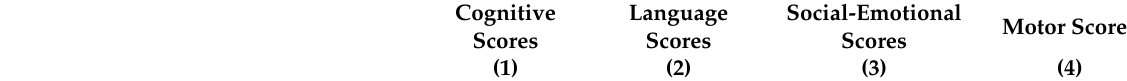
Table 7. Heterogeneous effects of caregiver’s mental health on ECD across certain variables from socioeconomic status, n =